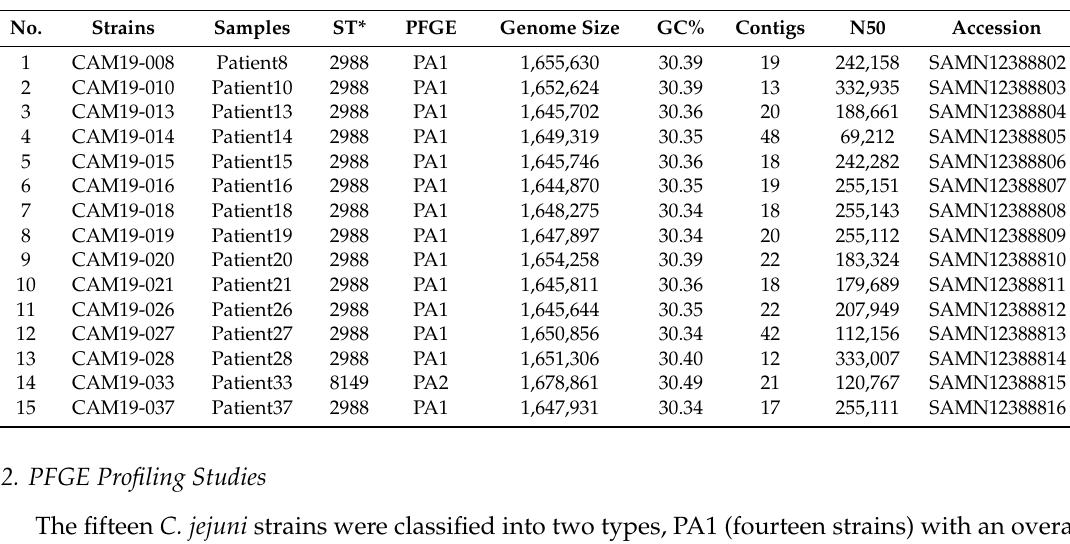
Table 1. Overview of the genome sequences of Campylobacter jejuni isolates.